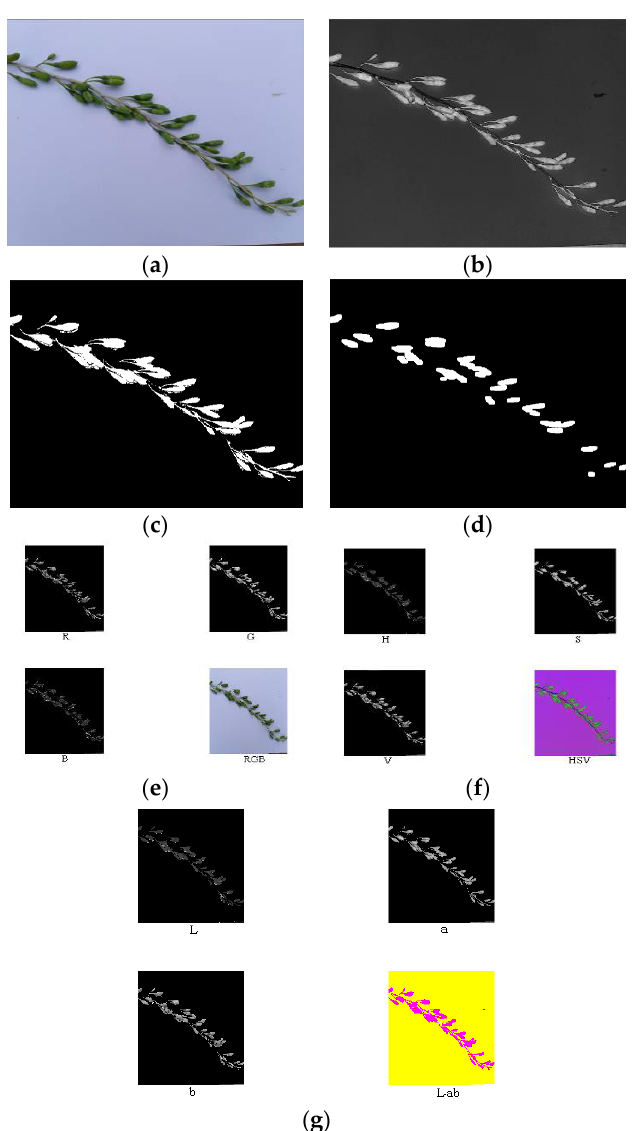
Figure 11. Original image ( a ), component S ( b ), binary processing ( c ), morphology processing ( d ), masks of RGB model ( e ), masks of HSV model ( f ), and masks of lab model ( g ) of the unripe fruit.